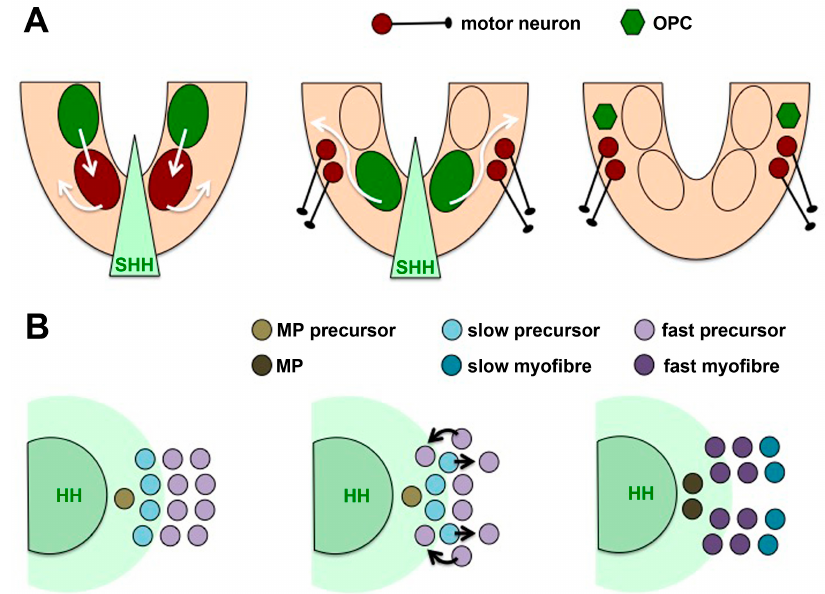
Figure 2. Cell movements accompanying temporal changes in competence for HH signalling. ( A ) In the ventral neural tube, progenitors in a more ventral domain (brown) are induced to become motor neurons by sonic hedgehog (SHH) (light green) from the notochord and floor plate. As these motor neurons differentiate, they move away radially and are replaced by progenitors from a more dorsal domain (dark green) which respond to SHH by differentiating into oligodendrocyte precursor cells (OPC) [104–107]; ( B ) In the zebrafish myotome, HHs from axial tissues induce muscle pioneer cells (brown) and slow-twitch myofibres (blue). After they have received the signal, the slow precursor cells (light blue) move away radially and are replaced by fast-twitch muscle precursor cells (light purple) that differentiate in response to HH [109,110].